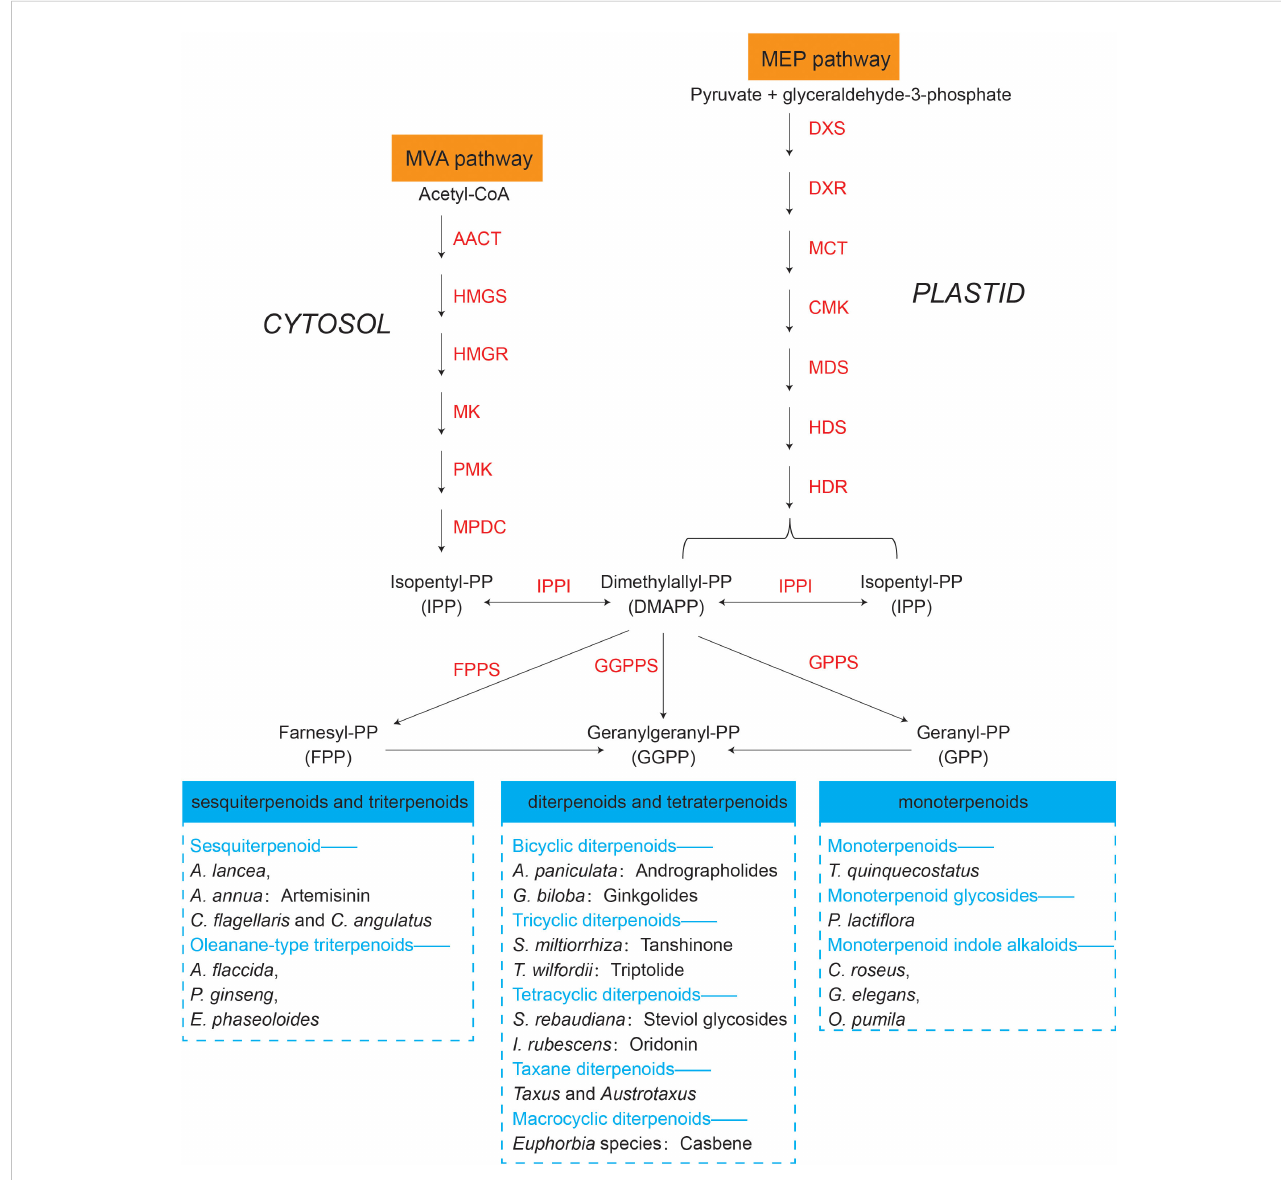
FIGURE 4 Terpenoids synthesized by representative medicinal plants through mevalonate (MVA) and methylerythritol phosphate (MEP) pathways. The key proteins involved in the two pathways are in orange. AACT, acetoacetyl-CoA thiolase; HMGS, 3-hydroxy-3-methylglutaryl-CoA synthase; HMGR, 3-hydroxy-3- methylglutaryl-CoA reductase; MK, mevalonate kinase; PMK, phosphomevalonate kinase; MPDC, mevalonate diphosphate decarboxylase; DXS, 1-deoxy- d-xylulose 5-phosphate synthase; DXR, 1-deoxy-d-xylulose 5-phosphate reductoisomerase; MCT, 2C-methyl-d-erythritol 4-phosphate cytidyl transferase; CMK, 4-diphosphocytidyl-2C-methyl-d-erythritol kinase; MDS, 2C-methyl-d-erythritol 2,4-cyclodiphosphate synthase; HDS, 1-hydroxy-2- methyl-2- € -butenyl 4-diphosphate synthase; HDR, 1-hydroxy-2-methyl-2-(E)-butenyl 4-diphosphate reductase; IPPI, Isopentenyldiphosphate- isomerase; FPPS, farnesyl diphosphate (FPP) synthase; GGPPS, geranylgeranyl diphosphate (GGPP) synthase; GPPS, geranyl diphosphate (GPP) synthase. Representative medicinal plants containing various terpenoids are listed in the blue dashed